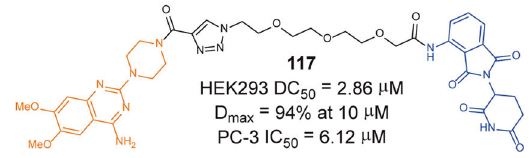
Fig. 29 The representative PROTAC targeting α 1A